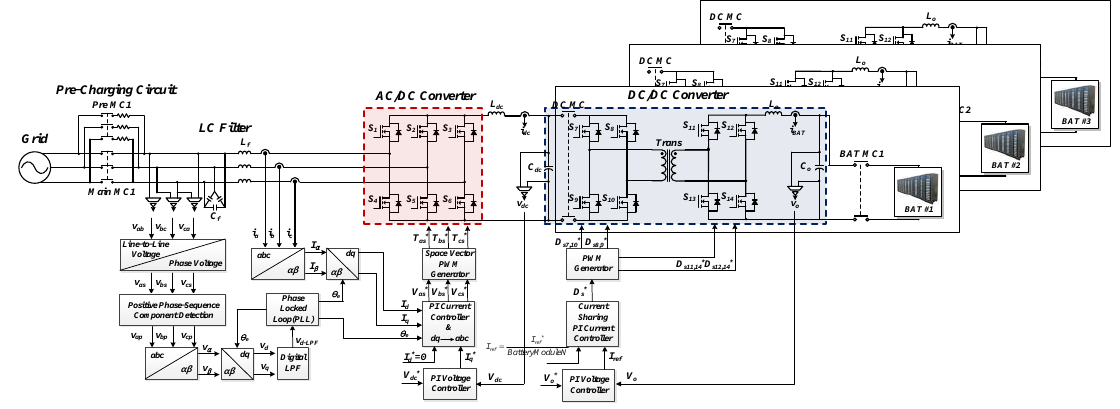
Figure 2. Proposed ESS circuit diagram.